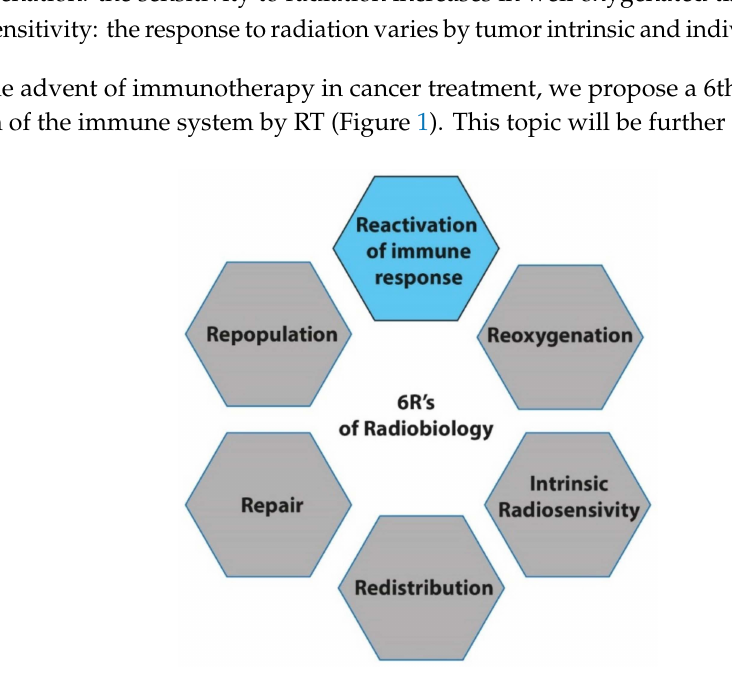
Figure 1. The reactivation of the immune response: the new R of